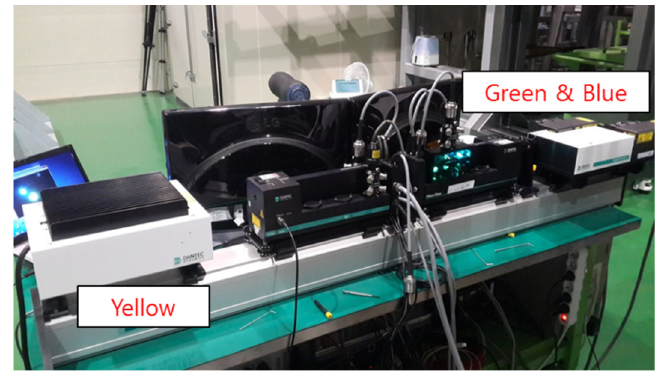
Figure 6. The DPSS laser system for the 3-D LDV.